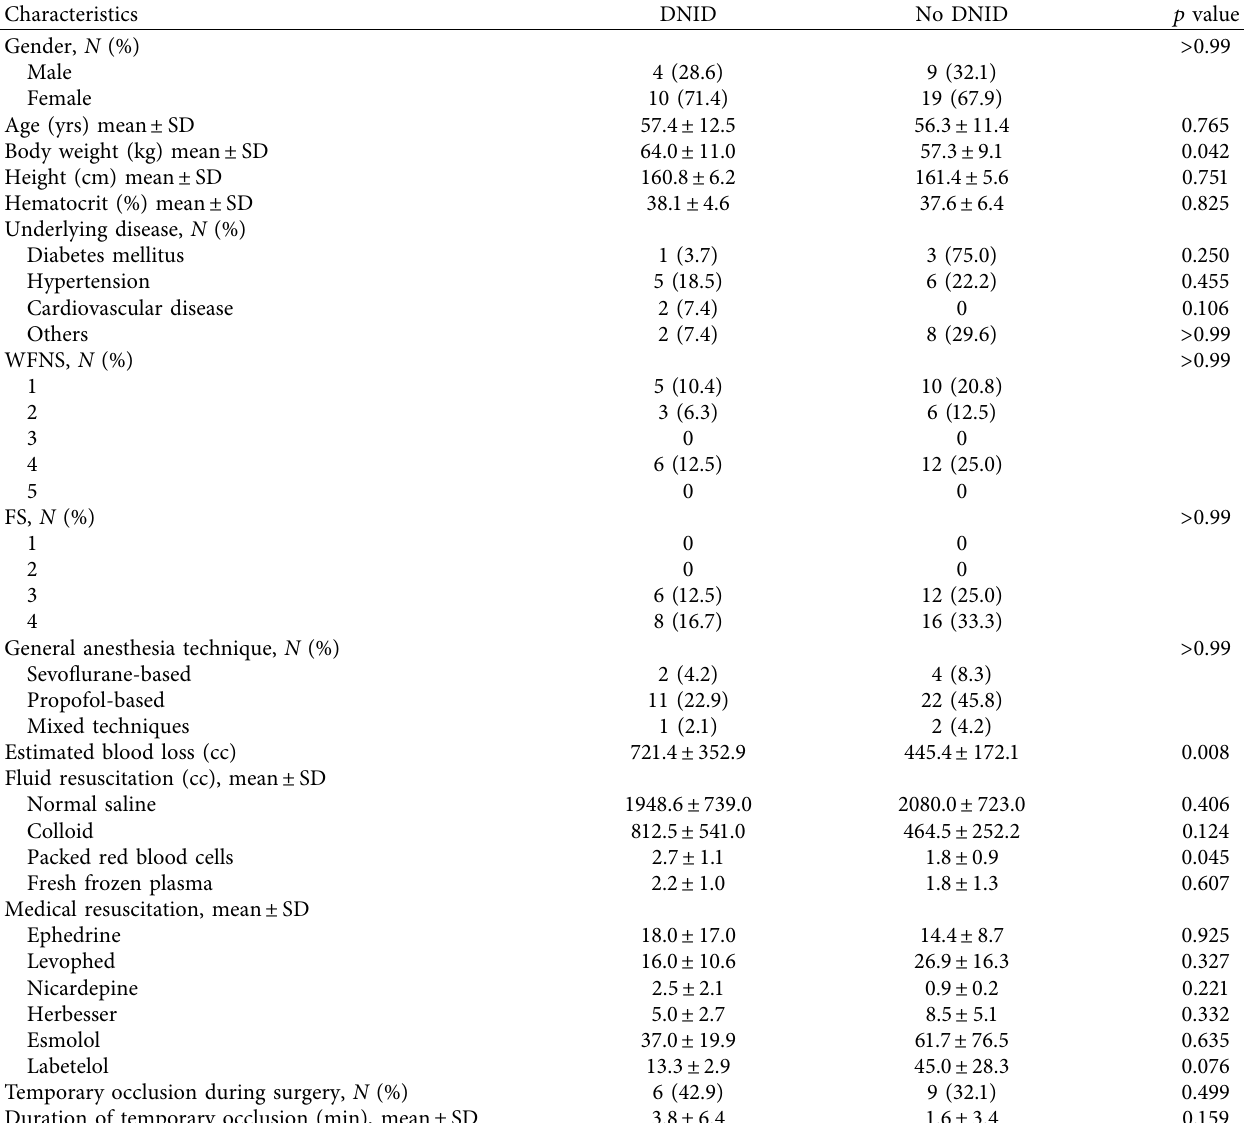
Table 1: Demographic